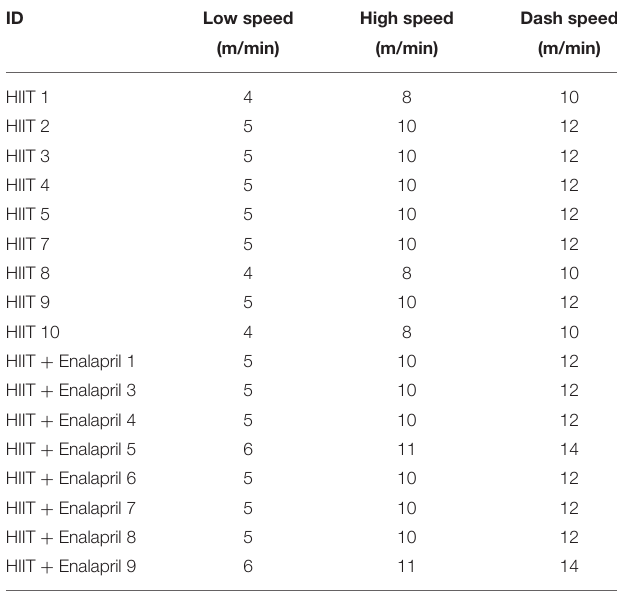
TABLE 1 | The dash speed of rats in HIIT